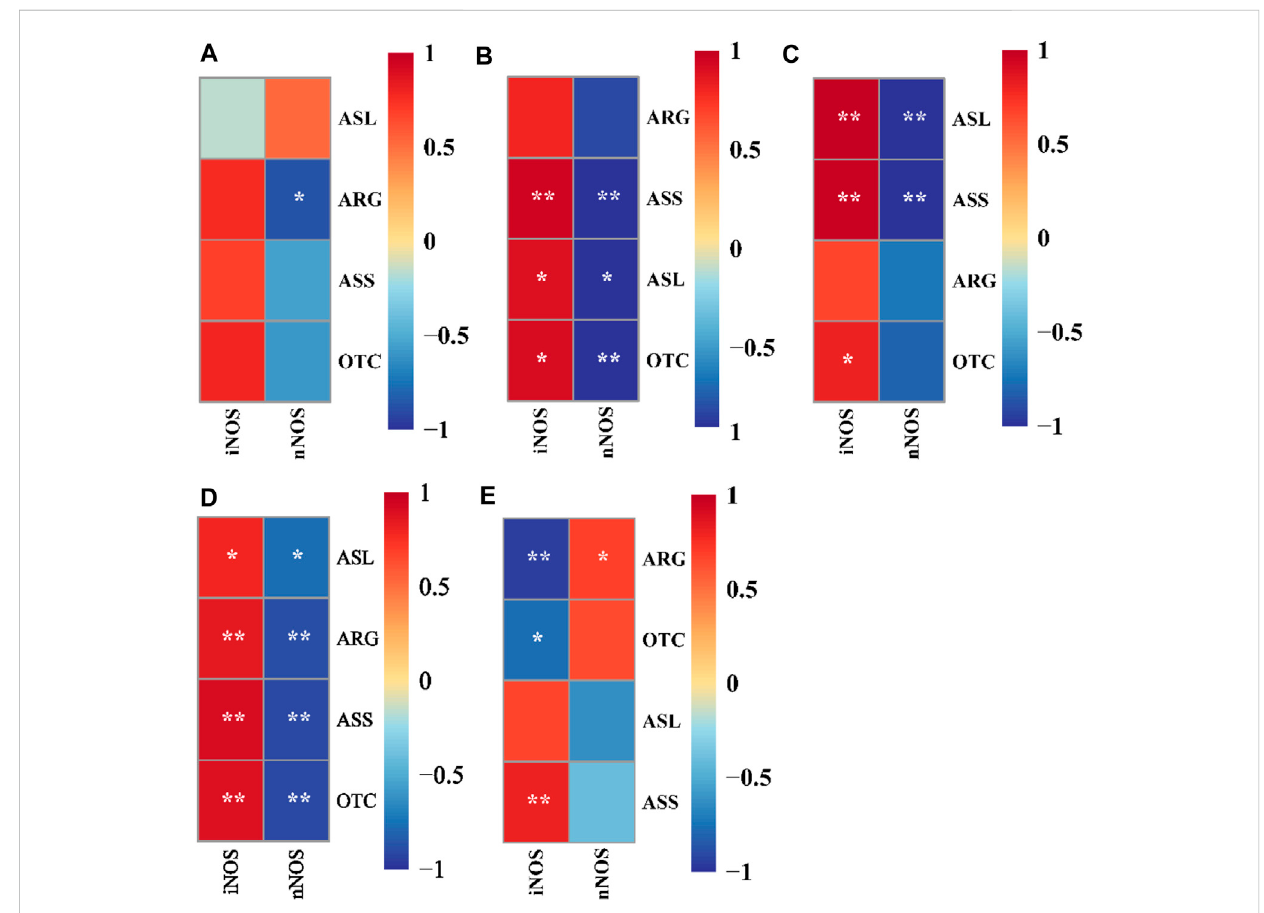
FIGURE 3 Correlation analysis between nitric oxide synthase activity and ammonia metabolism enzyme activity in yellow cat fi sh fed with different N-carbamylglutamate under 0.00 mg/L NH3 (A) , 0.08 mg/L NH3 (B) , and 0.16 mg/L NH3 (C) ammonia levels, respectively. Correlation analysis between nitric oxide synthase activity and ammonia metabolism enzyme activity in yellow cat fi sh fed diets with 0.00% (D) and 0.05% (E) N-carbamylglutamate underdifferentammonia levels.Asigni fi cantdifferencewasmarked as p at p < 0.05and pp at p < 0.001. nNOS;neuronalnitricoxide synthase, iNOS; inducible nitric oxide synthase, ASS; argininosuccinate synthetase, ASL; argininosuccinate lyase, ARG; arginase, OTC; ornithine